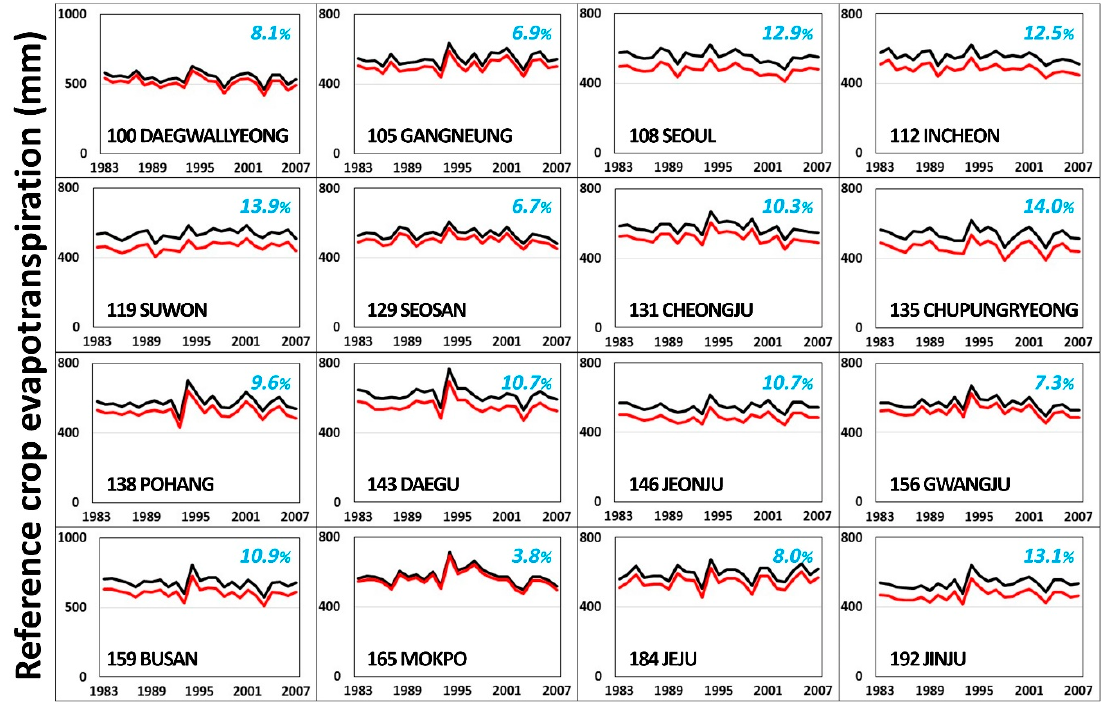
Figure 3. Estimates of the reference crop evapotranspiration ( ET (cid:2868) ) during the growing season of paddy rice (May to September) using the recommended (black solid line) and calibrated A-P coefficients (red solid line) for the period 1983–2007. The average difference between the two estimates of ET (cid:2868) for the study period is presented as a percentage in sky blue (e.g., 8.1% for Daegwallyeong).